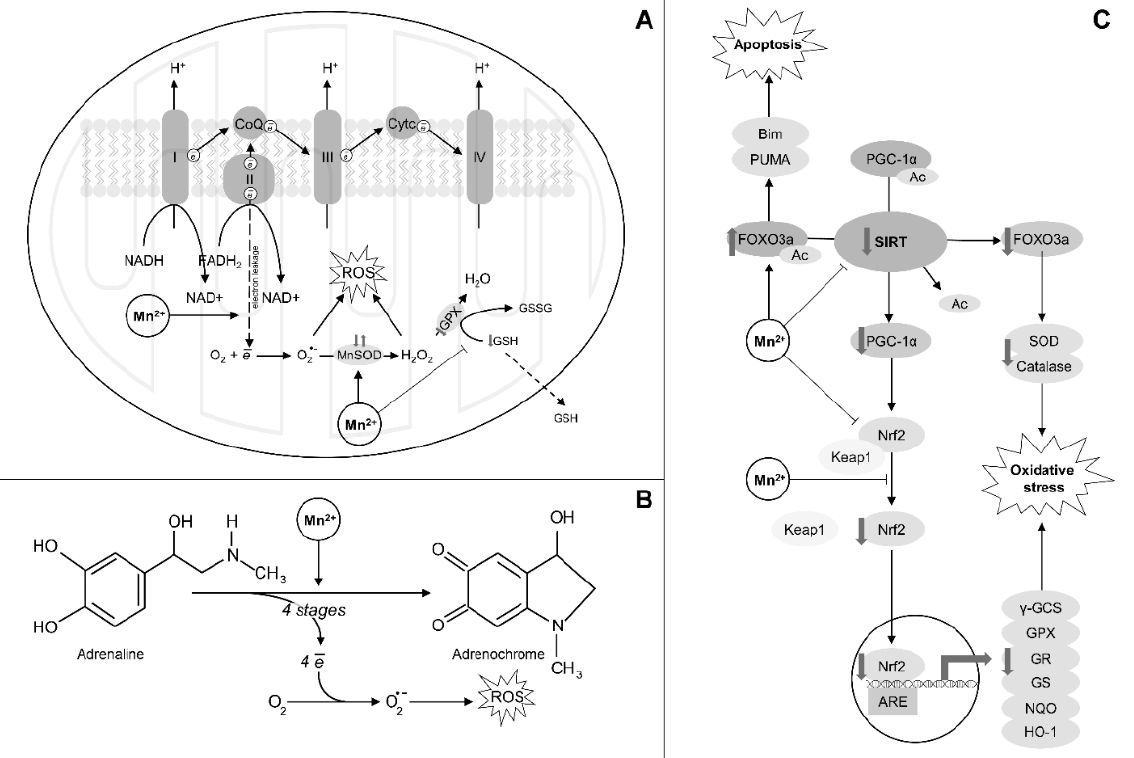
Figure 2. The potential mechanisms of Mn-induced oxidative stress. ( A ) Mn overexposure increases electron leakage and superoxide generation at electron transport chain complex II and increases MnSOD-dependent hydrogen peroxide formation [94,95]. Depression of antioxidant enzymes and loss of low-molecular weight antioxidants in response to Mn exposure also contribute to increased ROS accumulation [94]. ( B ) Mn increases adrenaline oxidation to adrenochrome with subsequent overproduction of superoxide [97]. ( C ) The impact of Mn on redox homeostasis may also be regulated at transcriptional level. Specifically, Mn-induced sirtuin down-regulation [98] results in increased acetylation of FOXO3a and PGC1 α . Increased PGC1a acetylation is associated with reduced Nrf2 expression and down-regulation of Nrf2 target genes including γ -glutamylcysteine synthetase ( γ -GCS), glutathione peroxidase (GPX), glutathione reductase (GR), glutathione synthetase (GS), NAD(P)H Quinone Dehydrogenase 1 (NQO-1), heme oxygenase 1 (HO-1) [98]. Mn exposure may also affect Nrf2 signaling through alterations of Keap1 expression [98]. In turn, increased FOXO3a acetylation results in decreased SOD and catalase expression that are up-regulated by deacetylated form, as well as promotes proapoptotic signaling through Bim and PUMA [103].